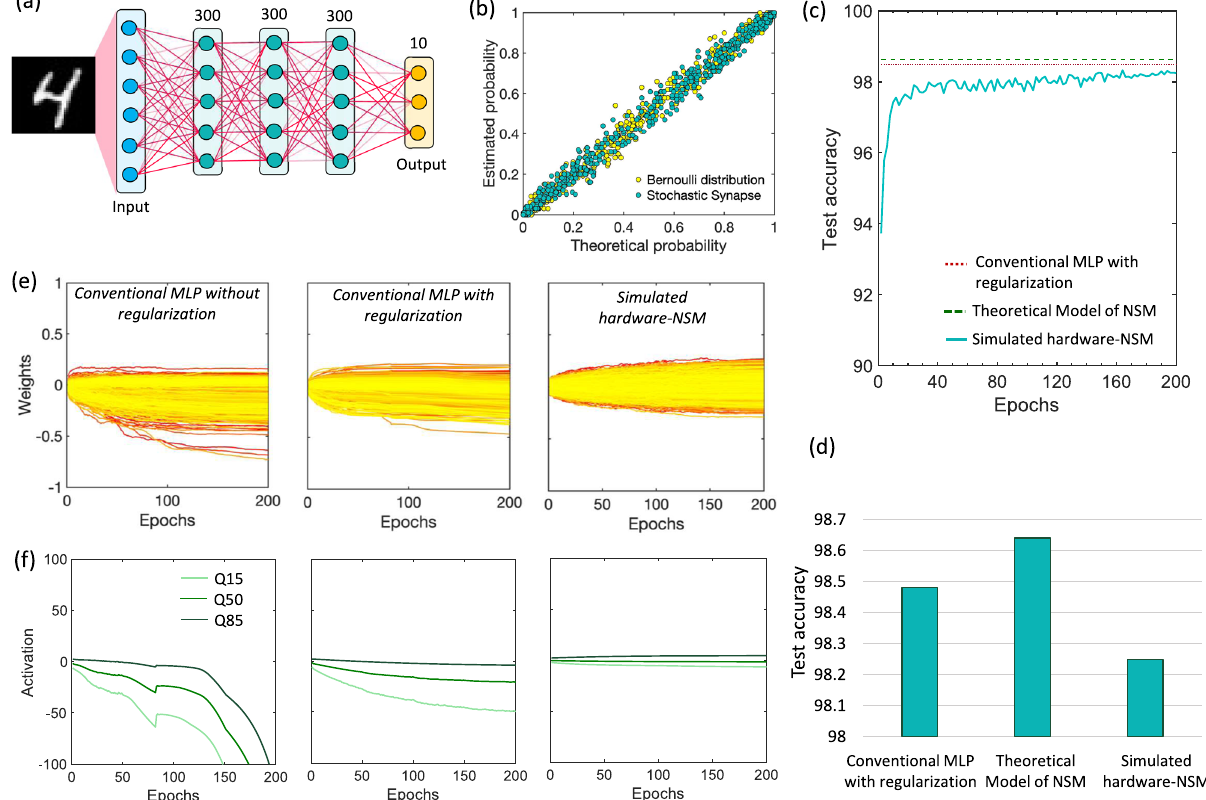
Fig. 4 Hardware NSM performing image classi fi cation and exhibiting self-normalization. a Network architecture of the NSM consisting of an input layer, three hidden fully connected layers and an output layer. b Exact match witnessed between the measured switching probability of the stochastic selector device and theoretically predicted probability for a Bernoulli distribution, highlighting that our stochastic selector device can inject Bernoulli multiplicative noise. c Evolution of the test accuracy for the simulated hardware-NSM using the FeFET-based analog weight cell and the stochastic selector as a function of the epochs. d Comparison of the performance of the simulated hardware-NSM with a deterministic feedforward multilayer perceptron (MLP) and the theoretical NSM model with full precession synaptic weights and a Bernoulli multiplicative noise for the stochastic synapses. e Evolution of the weights of the third layer during learning for three different networks- an MLP without any regularization, an MLP with additional regularization added and the simulated hardware-NSM. f Evolution of the 15th, 50th and 85th percentiles of the input distributions to the last hidden layer during training for all the three networks. Overall, NSM exhibits a tighter distribution of the weights and activation concentrated around its mean, highlighting the inherent self- normalizing feature. MLP multilayer perceptron, NSM neural sampling machine, Q